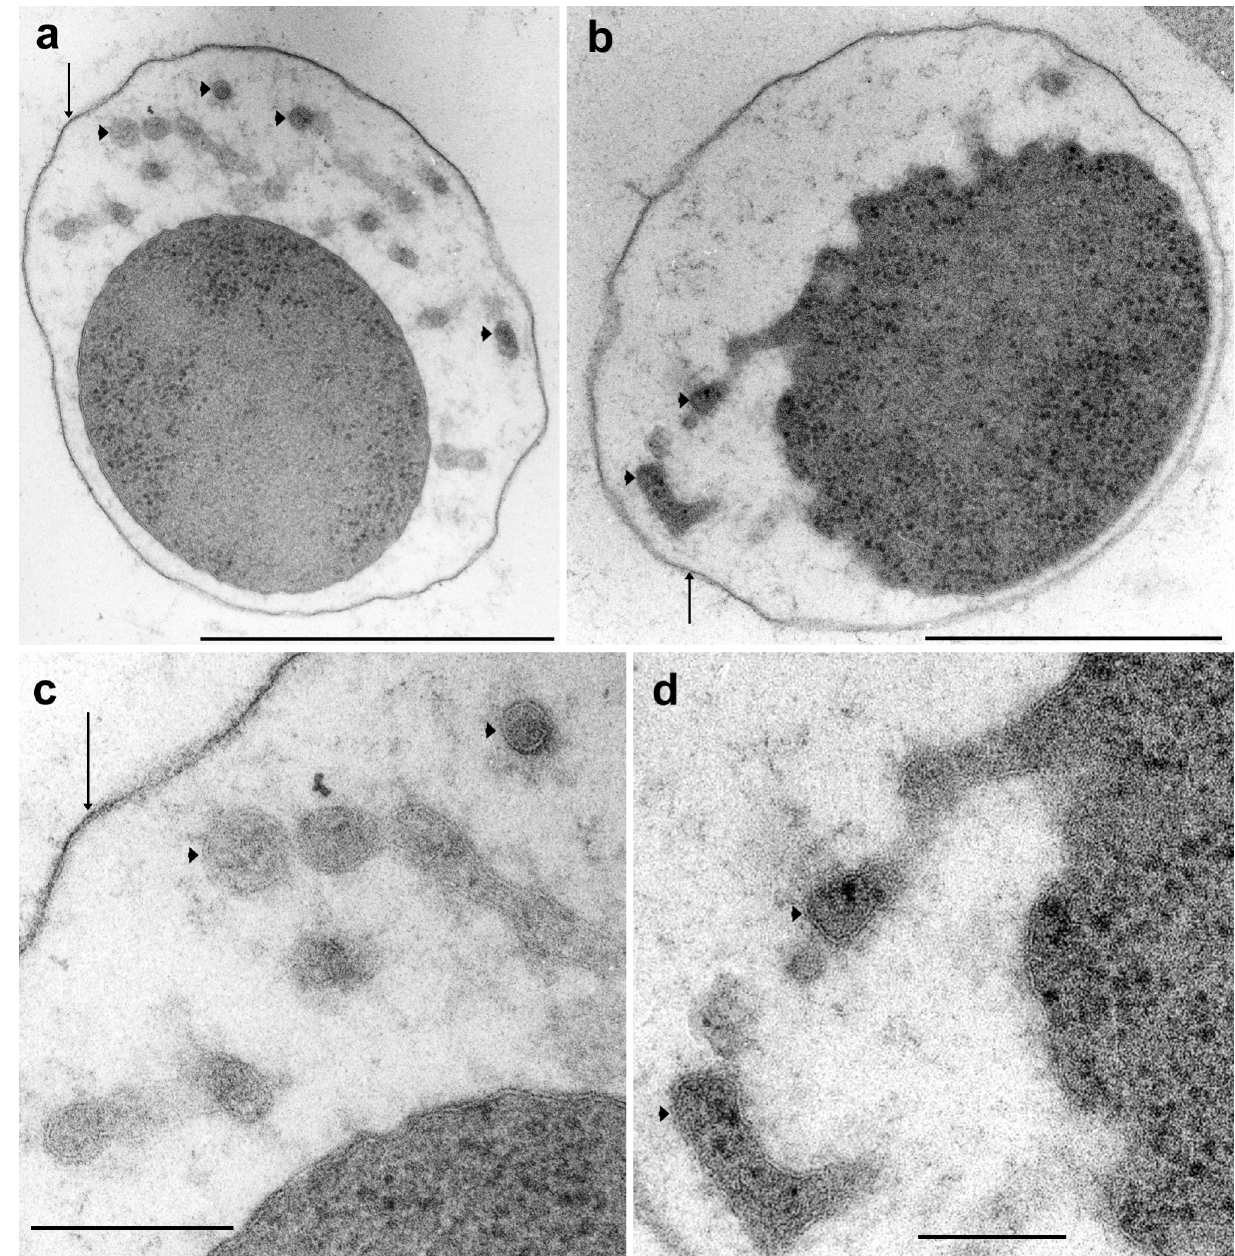
Figure 3. Electron micrographs of ultrathin sections of Ignicoccus , grown inside a capillary, high-pressure frozen and freeze-substituted. Arrow- heads point to periplasmic vesicles and arrows point to the outer membrane. (a, b) Low magnification micrographs, bar = 1 µm; and (c, d) detail at higher magnification, bar = 0.2